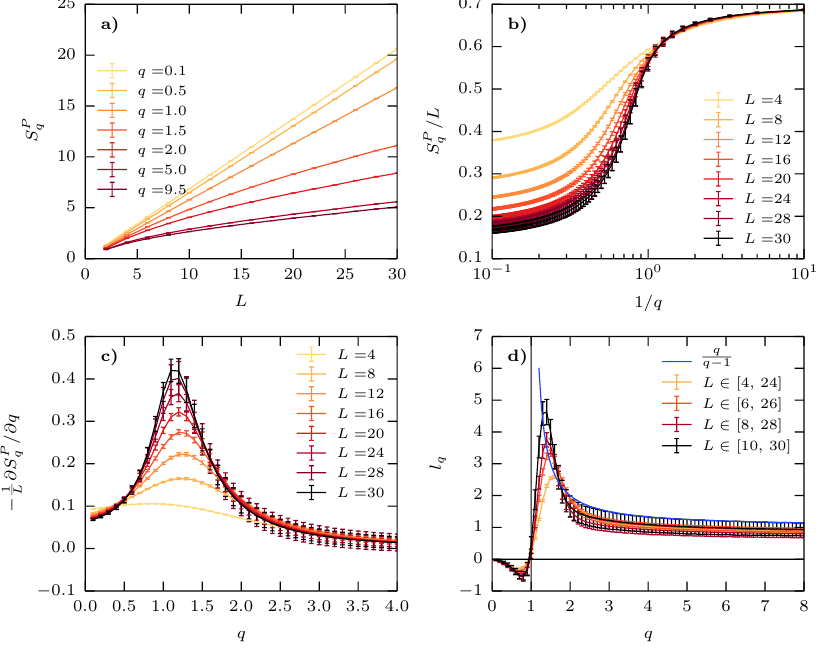
Figure 5: QMC results for the groundstate participation entropies S P ded in the L × L two-dimensional J directly from the histogram of sampled basis states. (a) Entropies as a function of the linear system size L for some representative values of the Rényi parameter q . (b) Intensive part S P plotted against 1 / q for varying lengths L . An inflection point is demonstrated in panel (c) where the derivative is peaked around q arithmic correction obtained from fits to the form Eq. (11) performed over various windows, as indicated on the plot. The analytic prediction Eq. (10) is also shown for q > 1 (blue line). Panels (c-d) clearly show a Rényi index transition at q